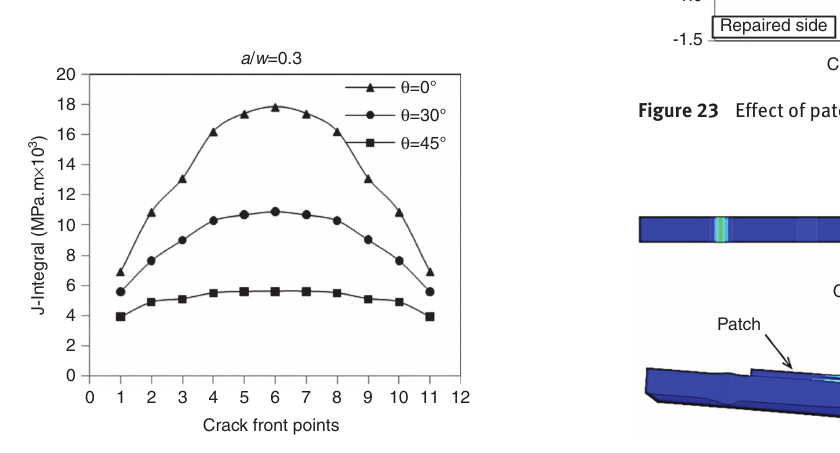
Figure 24 Unsymmetrical deformation in patched